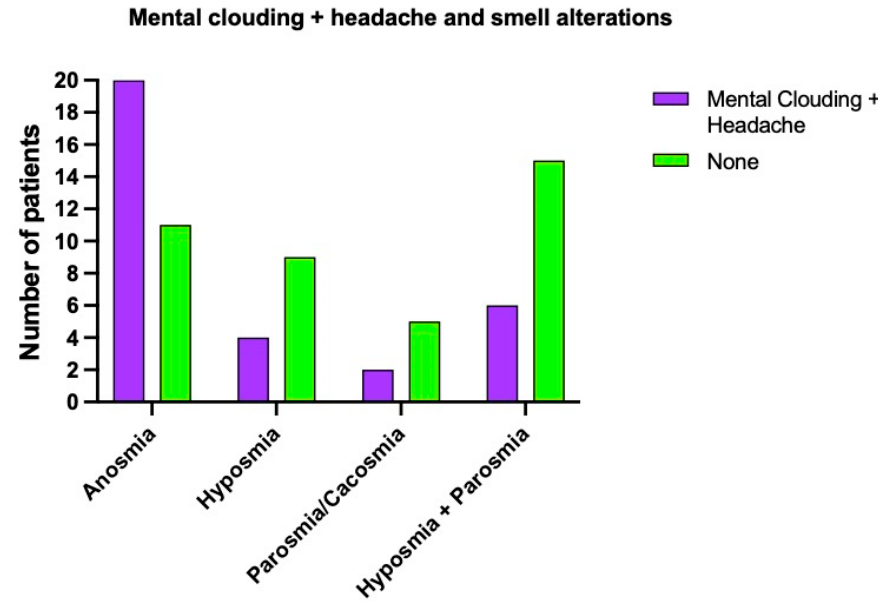
Figure 5. Smell alterations patients who reported both mental clouding and headache. Patients with mental clouding had higher risk of suffering from anosmia (OR: 19; p = 0.05) or hyposmia + parosmia (OR: 33; p = 0.01), hyposmia alone (OR: 15; p =